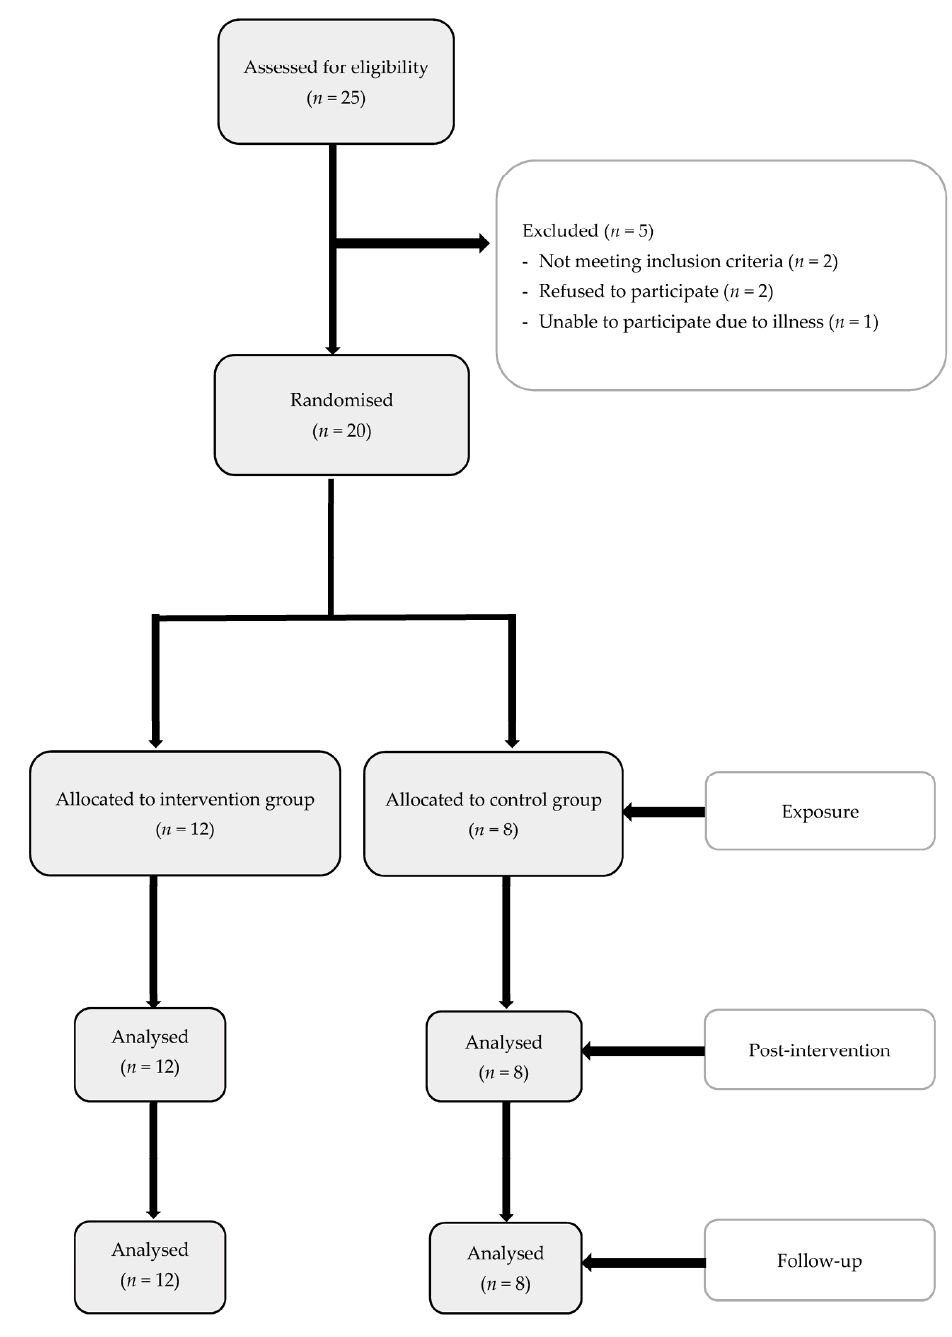
Figure 4. Diagram for the pilot study. Table 1. Comparison between groups at